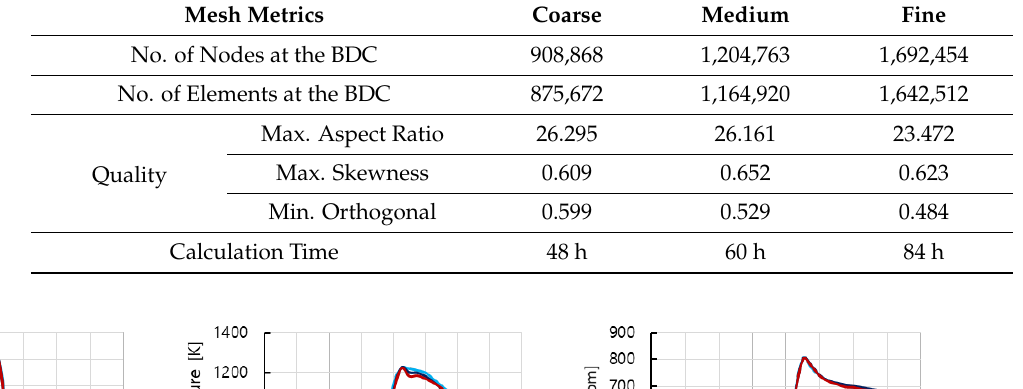
Table 7. Mesh properties and calculation time.